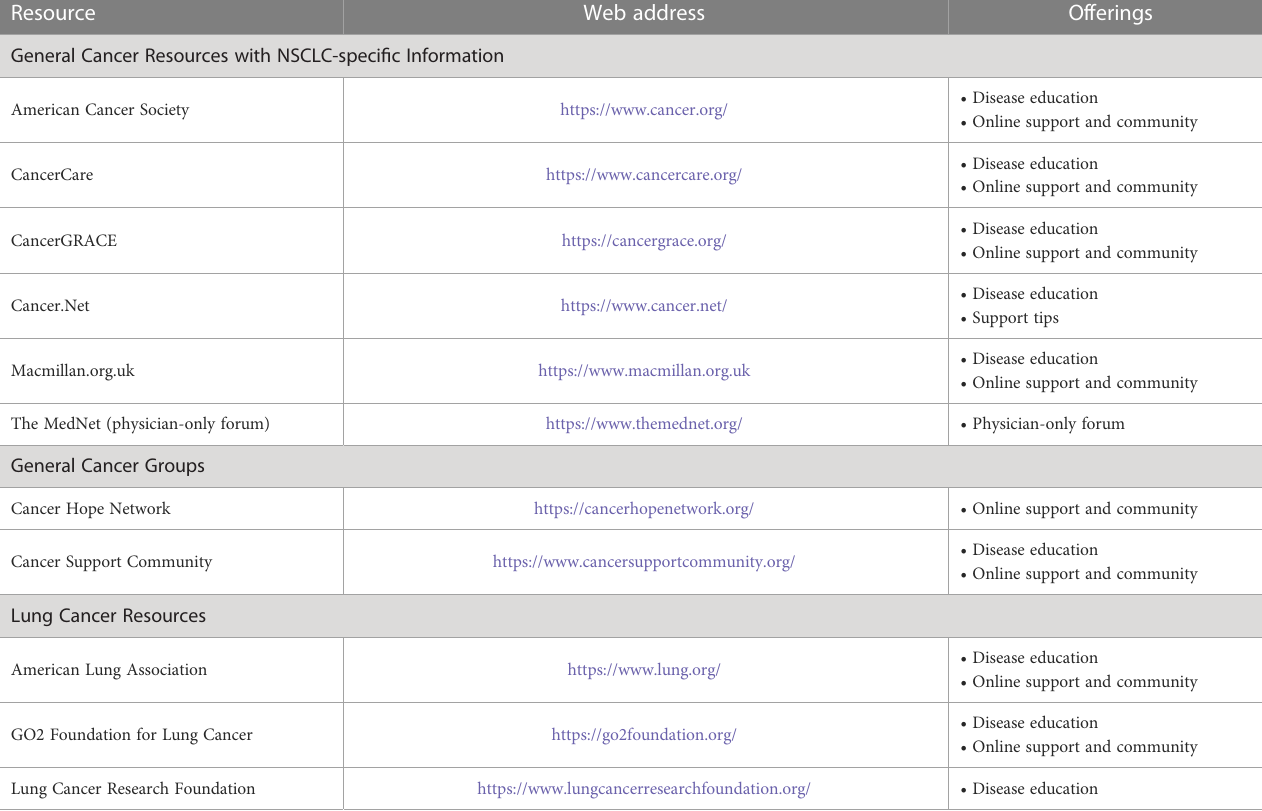
TABLE 2 Online non-small cell lung cancer (NSCLC) patient, family, and caregiver education resources.